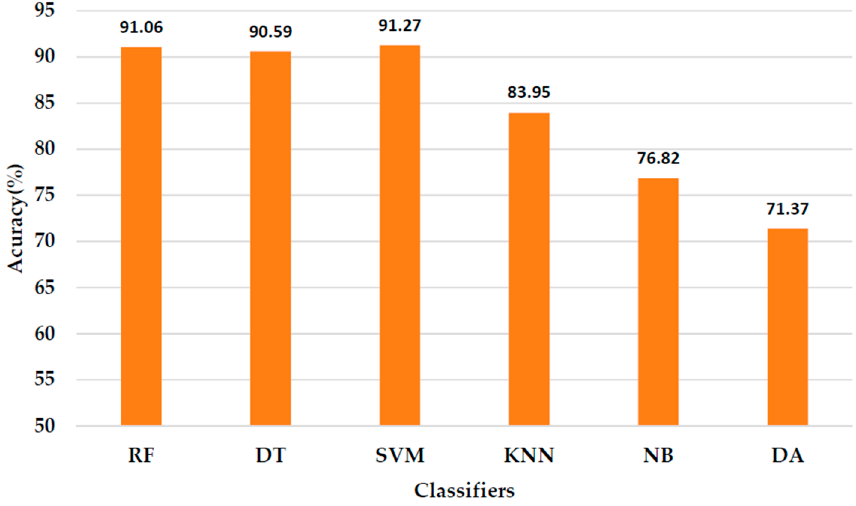
Figure 6. Results of different algorithms.